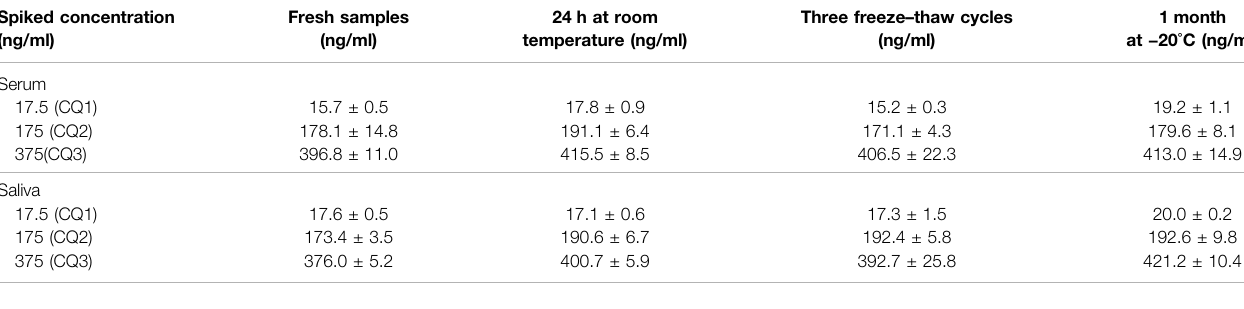
Fresh samples (ng/ml)